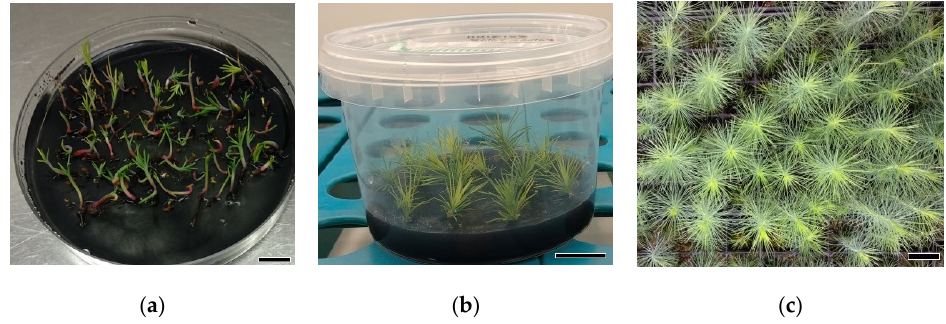
Figure 6. Germination and acclimatization of somatic plantlets from Pinus halepensis Mill. obtained from different embryogenic cell lines and maturation temperatures. ( a ) Somatic plantlets after two months in germination medium, bar = 1 cm; ( b ) plantlets cultivated after three months in the germination medium, bar = 2 cm; ( c ) plantlets derived from normal cotyledonary somatic embryos growing in the greenhouse, bar = 5 cm.